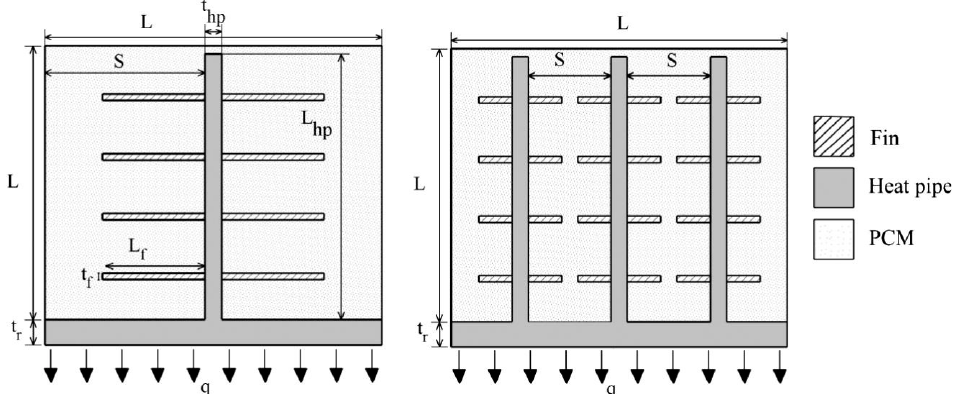
Figure 4. LHTES system assisted by finned heat pipes (Copyright 2016 Elsevier)